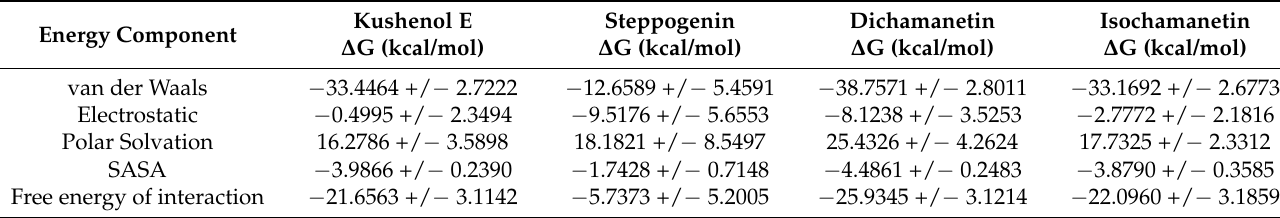
Table 3. Free energy of interaction of each flavonoid with